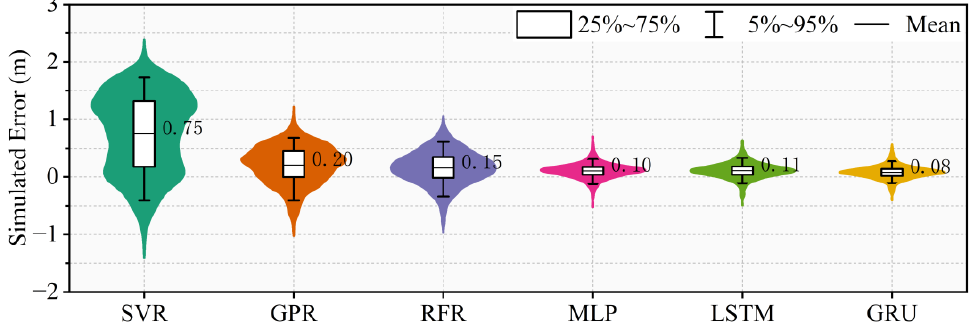
Figure 9. Violin plots of the simulated water level errors of Shashi Station by different ML models during the testing period.